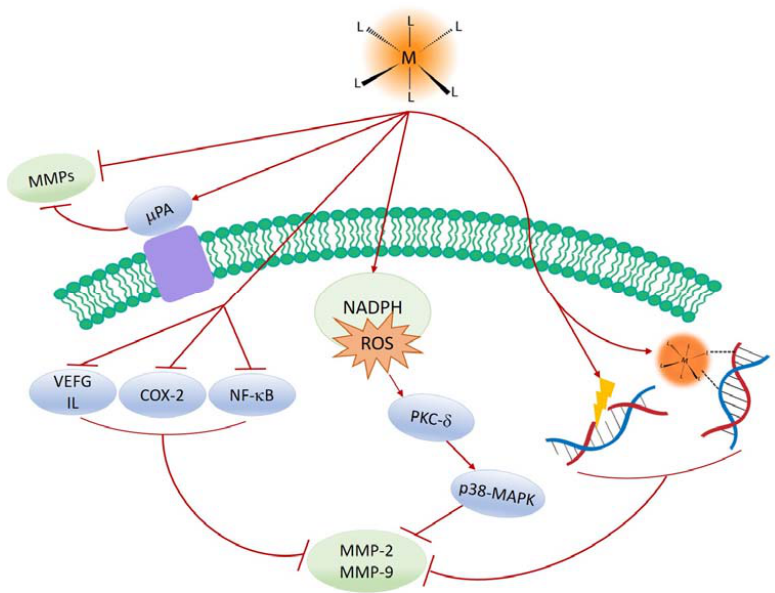
Figure 2. The proposed mechanisms for regulating MMPs by metal complexes in directly and indi ‐